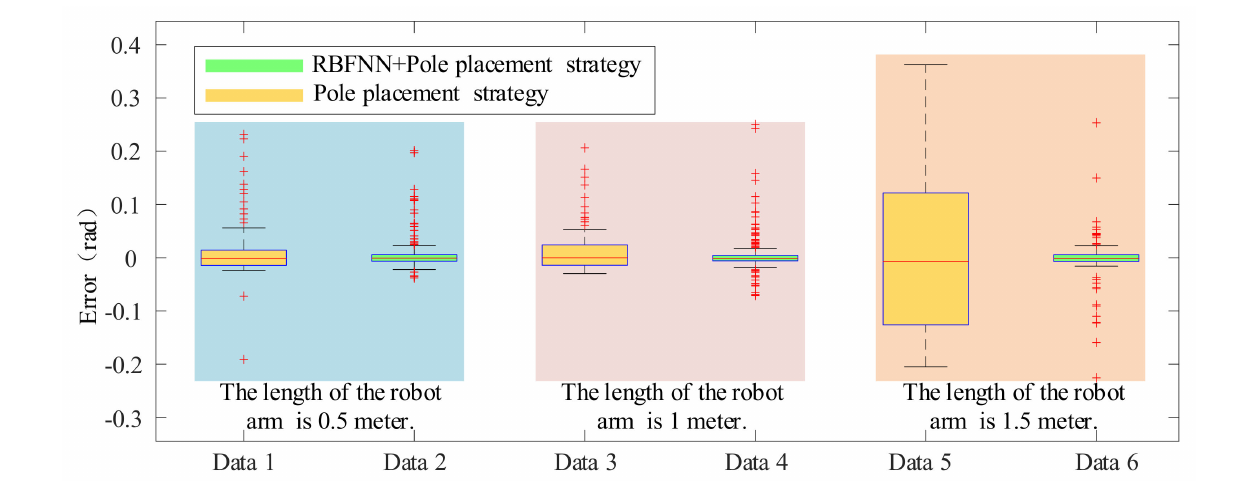
Figure 17. The data statistics results of the rotation angle error. Table 2. Error indicators of six groups of experimental